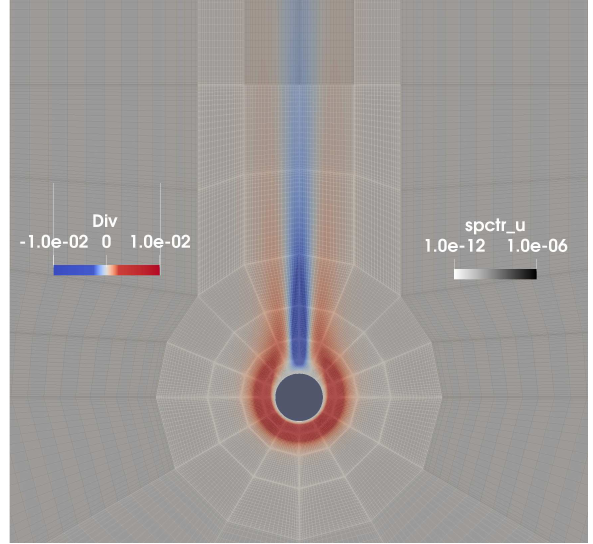
Fig. 7. Field of velocity divergence "Div" in natural convection problem with Ra = 1000. Spatial error estimate "spectr_T" for temperature field is projected onto the divergence field together with mesh grid, which belongs to approximation by polynomial of degree